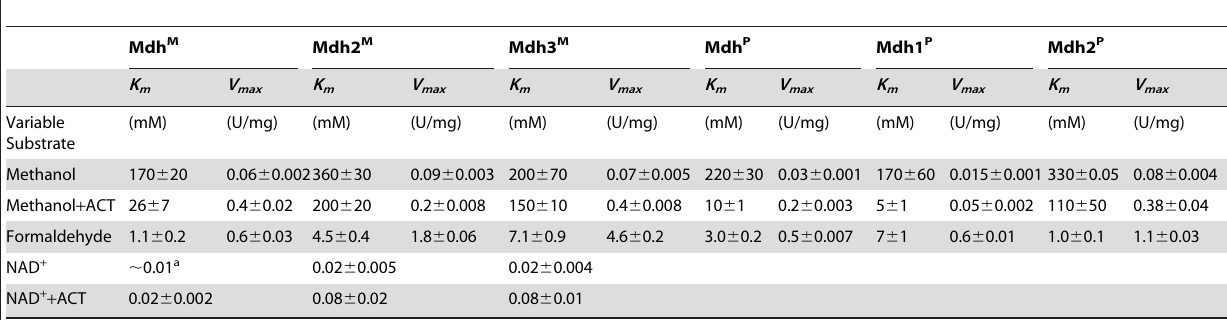
Table 2. In vitro kinetic constants of Mdhs in the presence and absence of